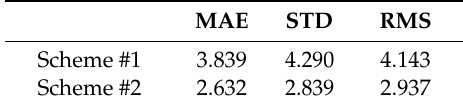
Table 5. Statistical result of PWV differences between various schemes and radiosonde for 7 days (Unit: mm).